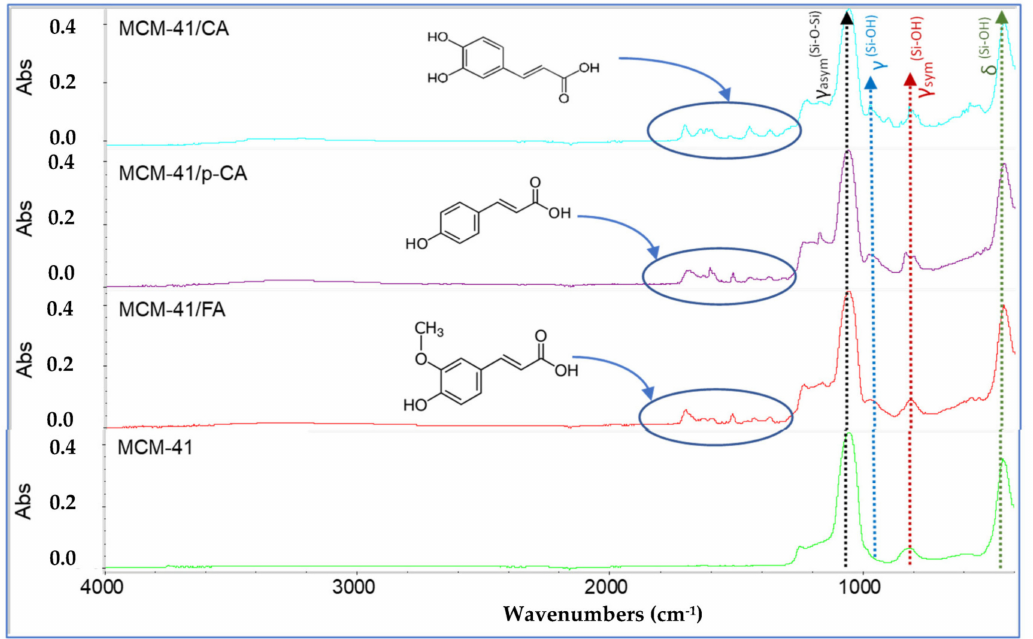
Figure 6. FTIR spectra of samples MCM-41, MCM-41/CA, MCM-41/p-CA and